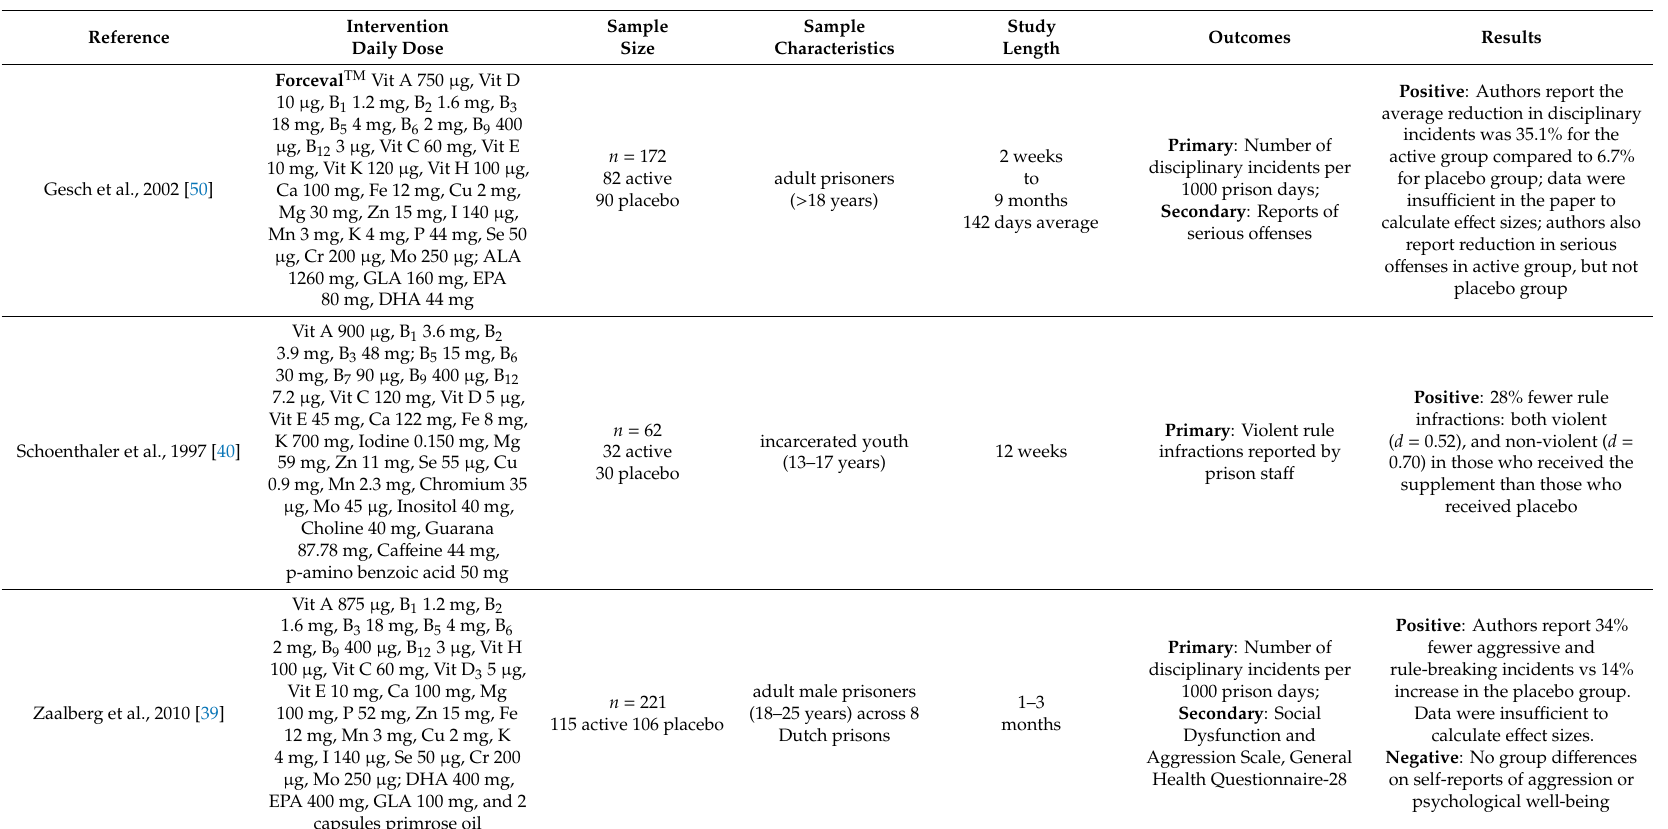
Table 4. Antisocial behavior studies ( n =